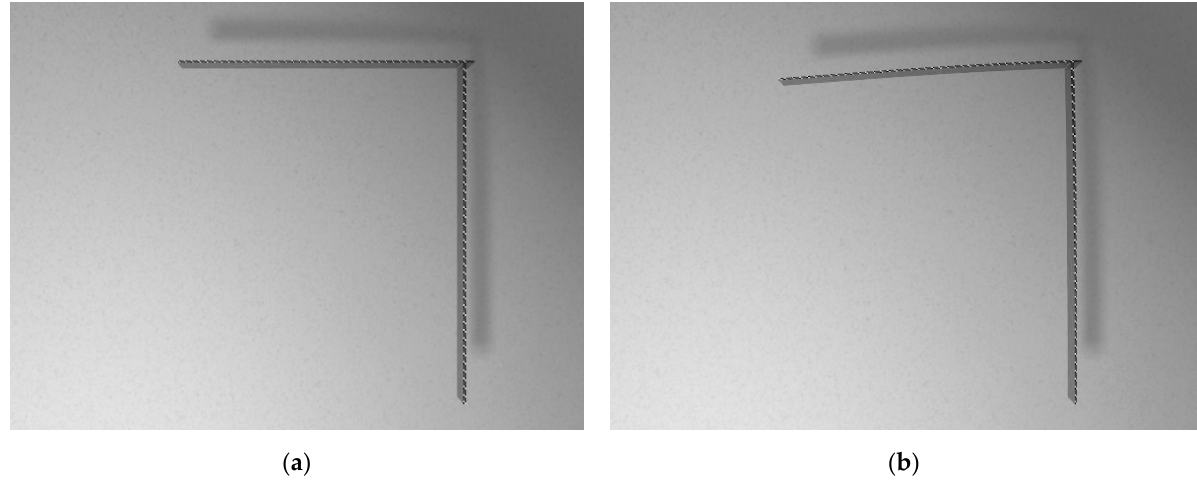
Figure 5. Renders generated using the proposed algorithm: unloaded structure ( a ) and loaded structure ( b ).